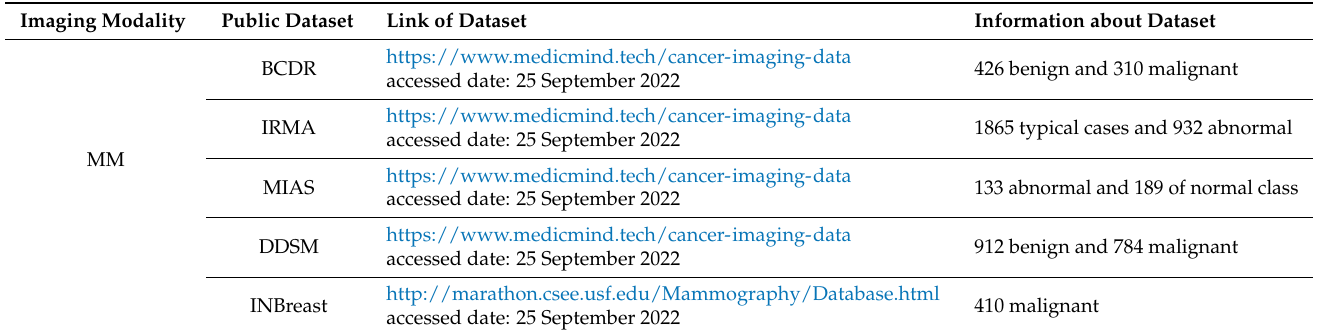
Table 2. Public datasets for different imaging modalities for breast cancer